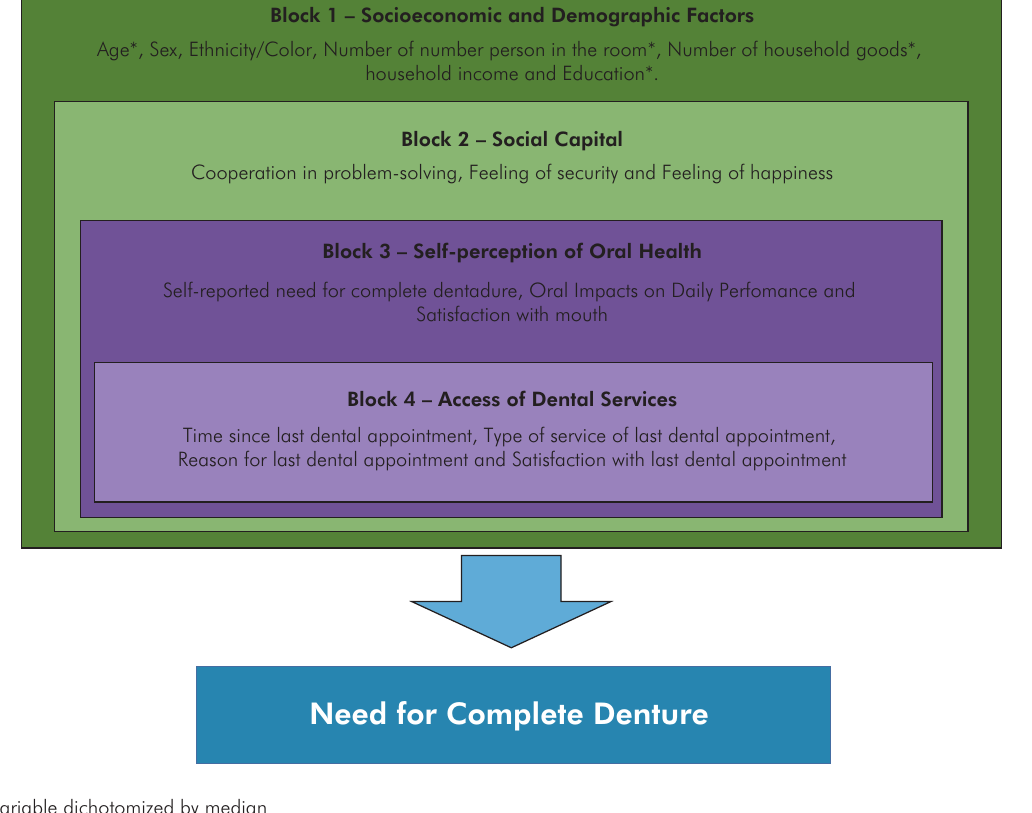
Figure 2. Theoretical model adapted for the